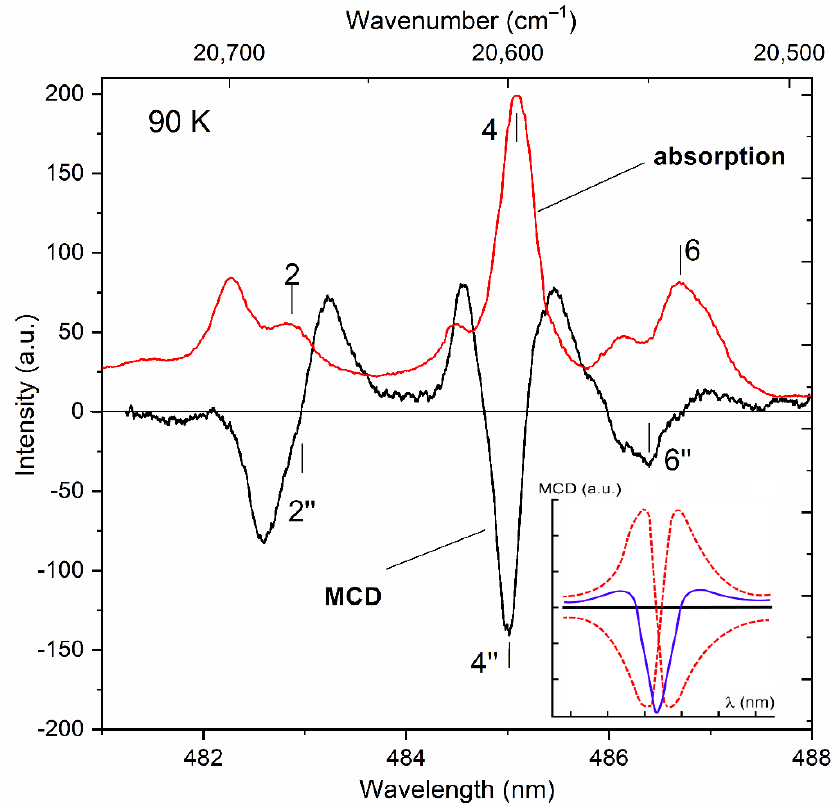
Figure 6. Spectral dependences of the MCD (red solid) and optical absorption (black line) of the KTF crystal at T = 90 K. The MCD spectrum is recorded in a magnetic field H = 5 kOe. The characteristic features of the MCD and absorption spectra are indicated in accordance with the transition scheme (Figure 5). The insert shows the result of the superposition of two opposite (in sign) spectral de- pendences of the MCD corresponding to the “ diamagnetic ” contributions to the MCD in the studied spectral region.